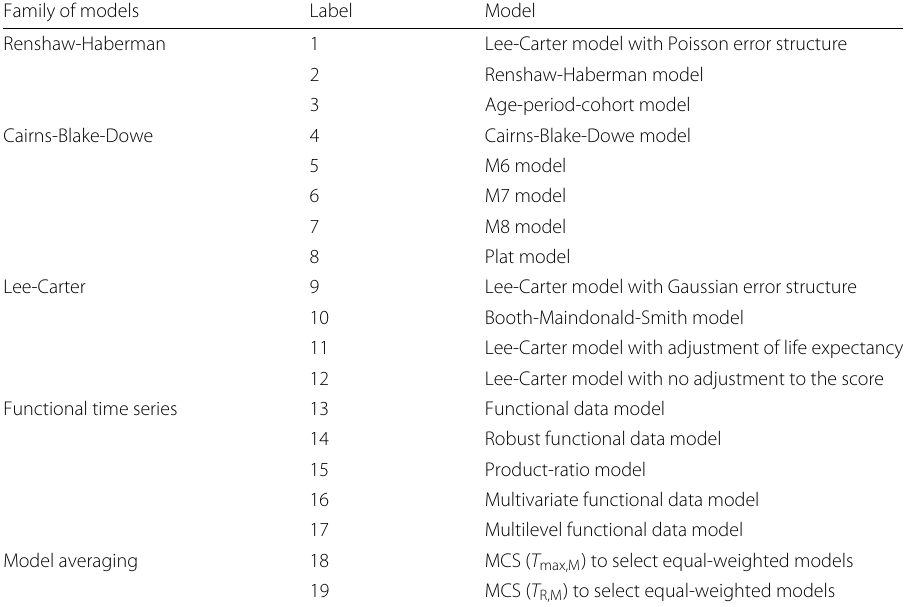
Table 1 A list of the 19 models considered Family of